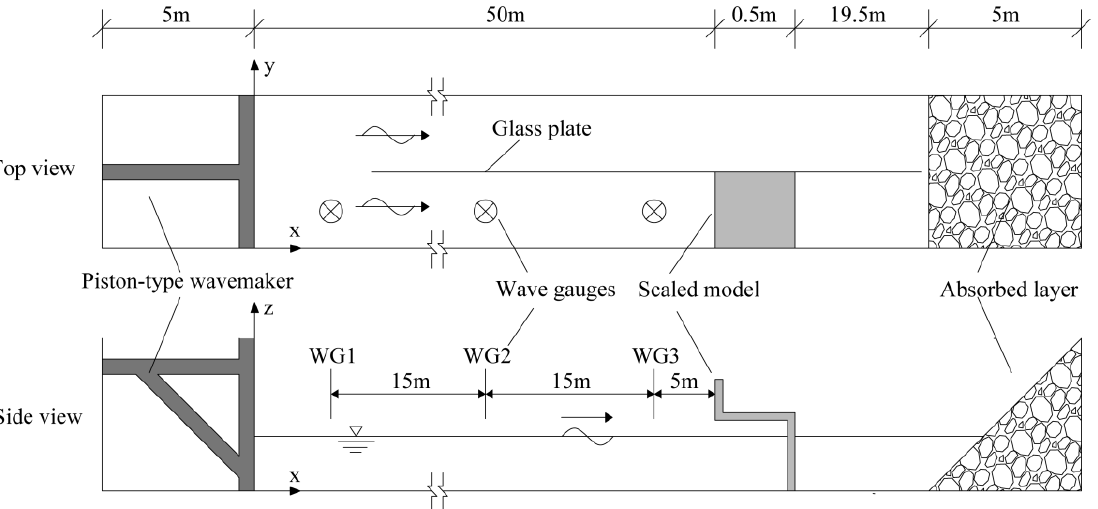
Figure 2. Two configurations of tested physical models; ( a ) the simple horizontal slab; ( b ) the verti- cal wall with overhanging horizontal cantilever slab. 2.2. Wave Conditions and Experimental Measurements Based on the prototype (field) wave conditions on which the model testing was based, a series of irregular wave conditions was generated for a range of significant wave heights H s between 0.05 and 0.15 m using a constant peak period of T p = 1.45 s, based on a JON- SWAP spectrum with a peak enhancement factor of γ = 3.3. For a summary of all the wave conditions and structural clearances used in the experiments, refer to Table 1. At the pro- totype (field) scale, this was equivalent to H s between 1.5 and 4.5 m at a fixed period of T p = 7.94 s. The water depth in the flume was held constant at 0.50 m during all experiments (equivalent to a 15 m depth at the prototype scale), with the structural clearance c varied by raising/lowering the models in the flume. Based on the wave peak period T p = 1.45 m used in the testing, the wavelength in the flume (inferred from linear wave theory) was L = 3.28 m. A total of 35 wave trials were conducted (denoted T1 to T35), with five of the conditions (denoted T16 to T20) repeated to include both the simple horizontal slab con- figuration (C1) and the vertical wall with an overhang configuration (C2) (Table 1). During the experiments, water elevations were recorded along the flume at three lo- cations (WG1 – WG3) using capacitance wave gauges with a sampling rate of 100 Hz (DJ800, from the China Institute of Water Resources and Hydropower Research), with the incoming significant wave height defined based on the measurements at the first wave gauge (WG1) (Figure 2, Table 2). The distances between these three wave gauges were determined for the separation of the incident and reflection waves [40,41]. To measure the wave impact pressures, 20 pressure sensors (WMS- 51P2J0L2M0, from Xi’an Microsensi- tive Instrument and Meter Co. LTD, Xi ’ an, China) located in the center axis of the tested